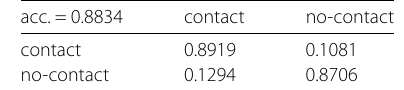
Table 8 Confusion matrix with accuracy of the BiLSTM-bin for event reconstruction acc. =